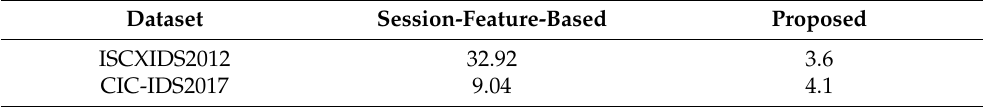
Table 9. The average number of packets required to detect an intrusion per